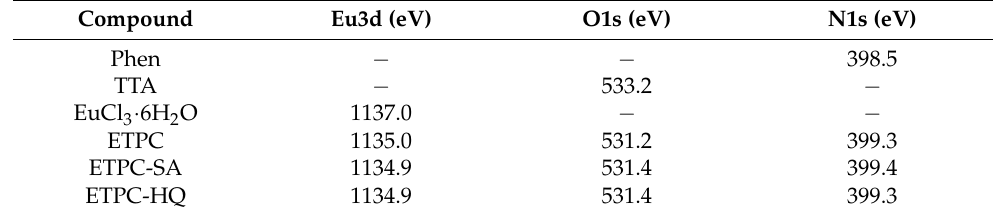
Figure 3. Composition characterization of ETPC, ETPC-SA, and ETPC-HQ. XPS spectra: (1) ETPC, (2) ETPC-SA, and (3) ETPC-HQ. Table 1. XPS data of the binding energies.